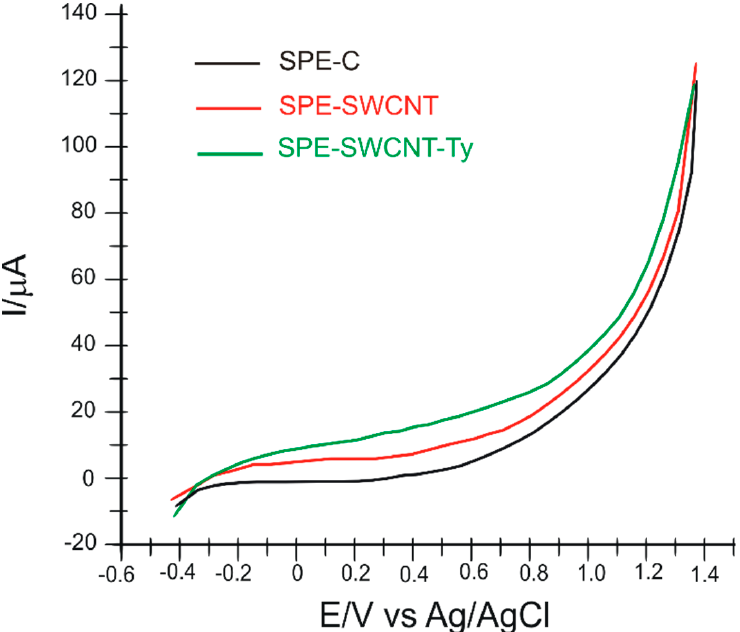
Figure 2. Differential pulse voltammograms recorded by the three sensors in 10 − 1 M PBS solution, pH 7.0, scan rate 0.1 V·s − 1 .